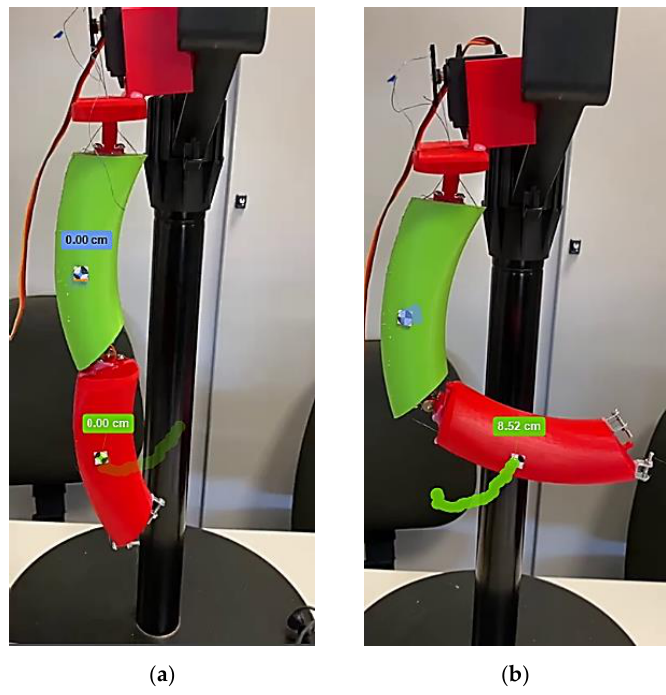
Figure 15. Full limb experimental test: ( a ) Starting position, ( b ) Final position.